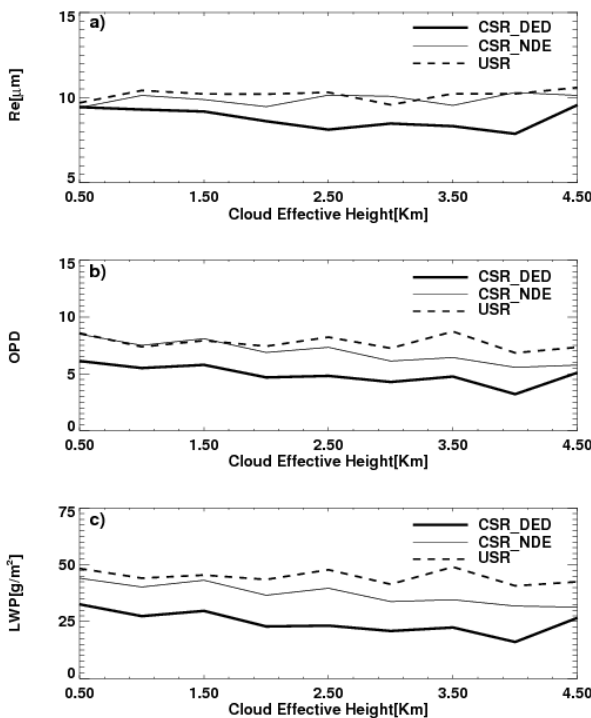
Fig. 11. Comparison of averaged water cloud properties as a function of effective cloud height for (a) Re , (b) OPD, and (c) LWP during spring (March to May).